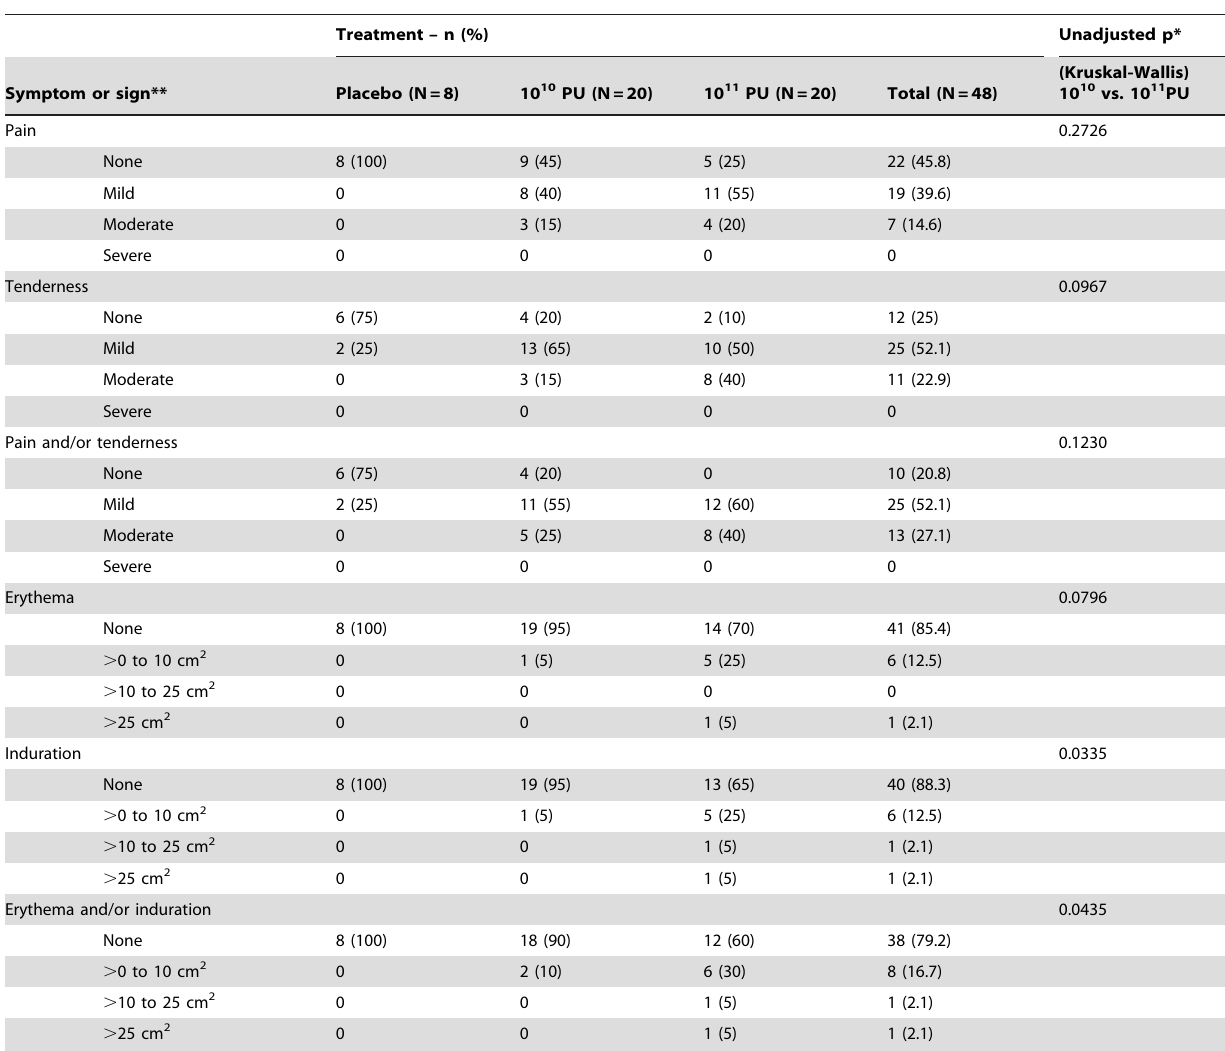
Table 2. Maximum local